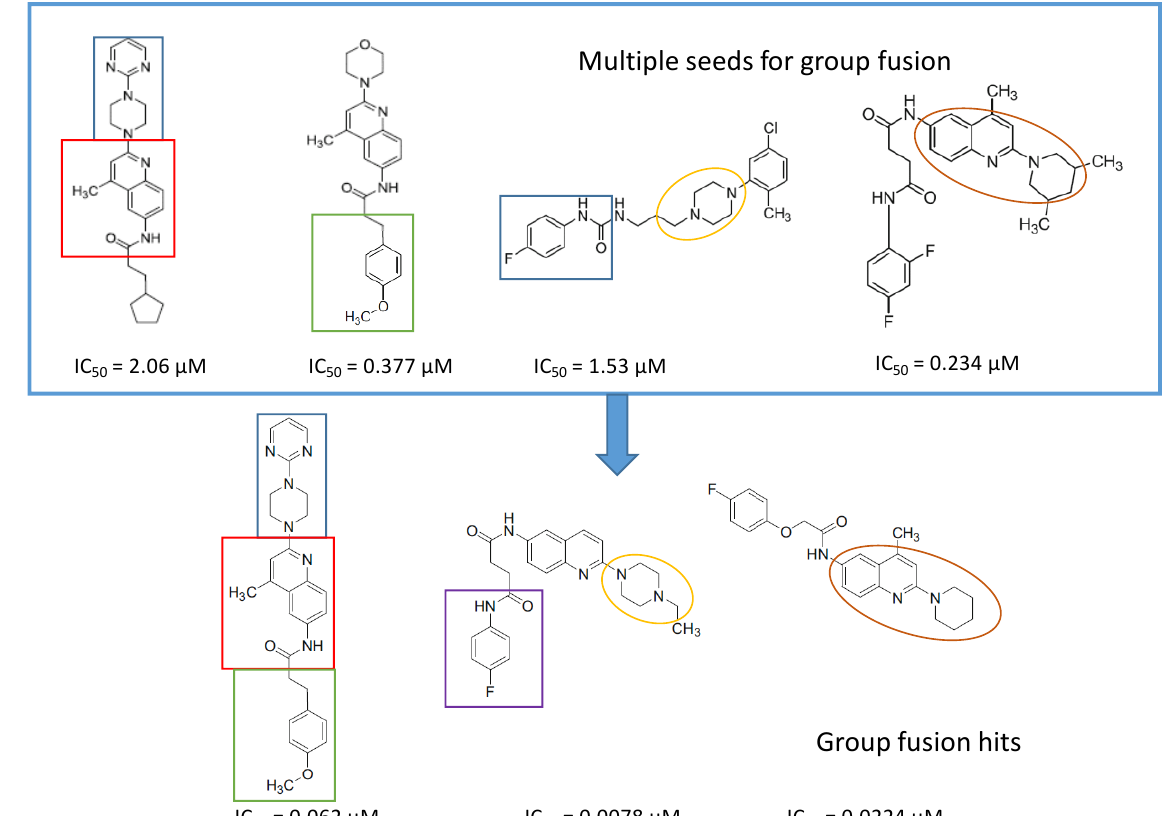
Figure 18. Three group fusion hits mixing the major structural motifs.